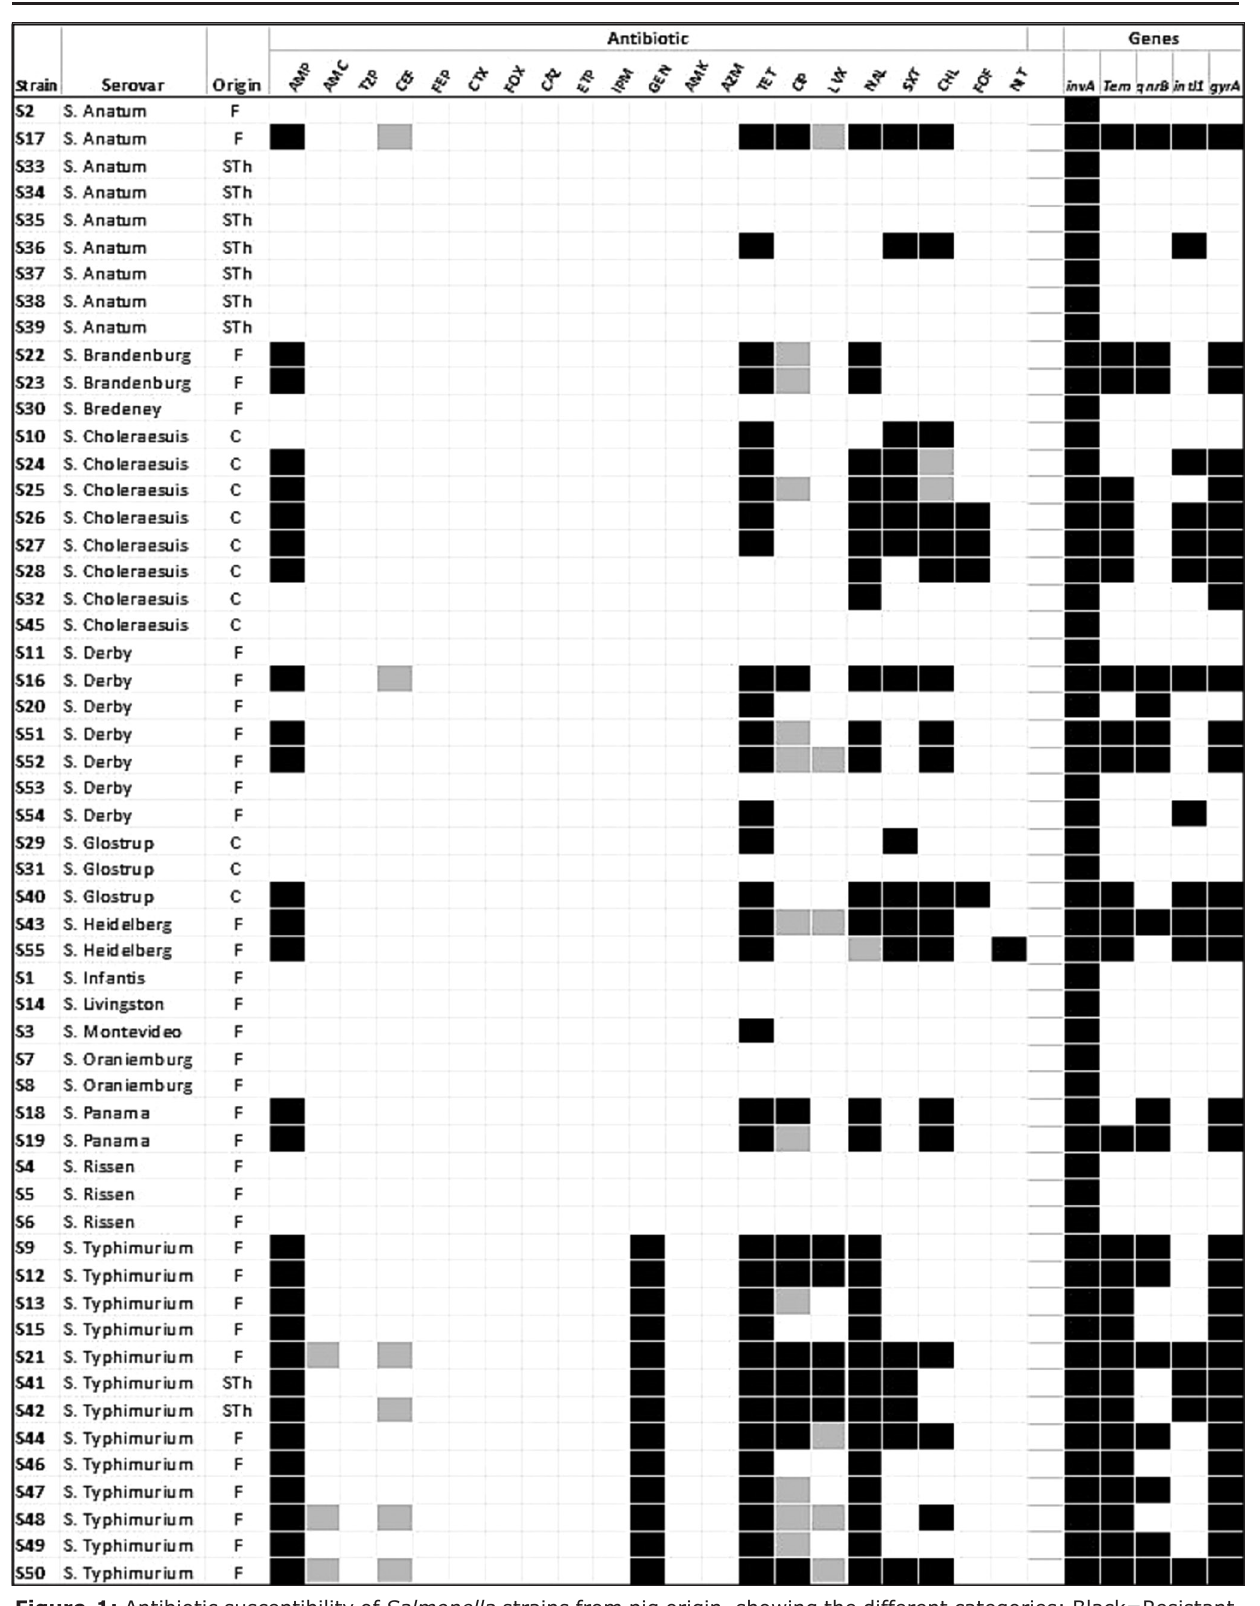
Figure-1: Antibiotic susceptibility of Salmonella strains from pig origin, showing the different categories: Black=Resistant, Gray=Susceptible with extended exposition, White=Susceptible; and also presence (black) or absence (white) of target resistance genes. The origins of the strain were field (F), slaughterhouse (Sth), and clinical cases